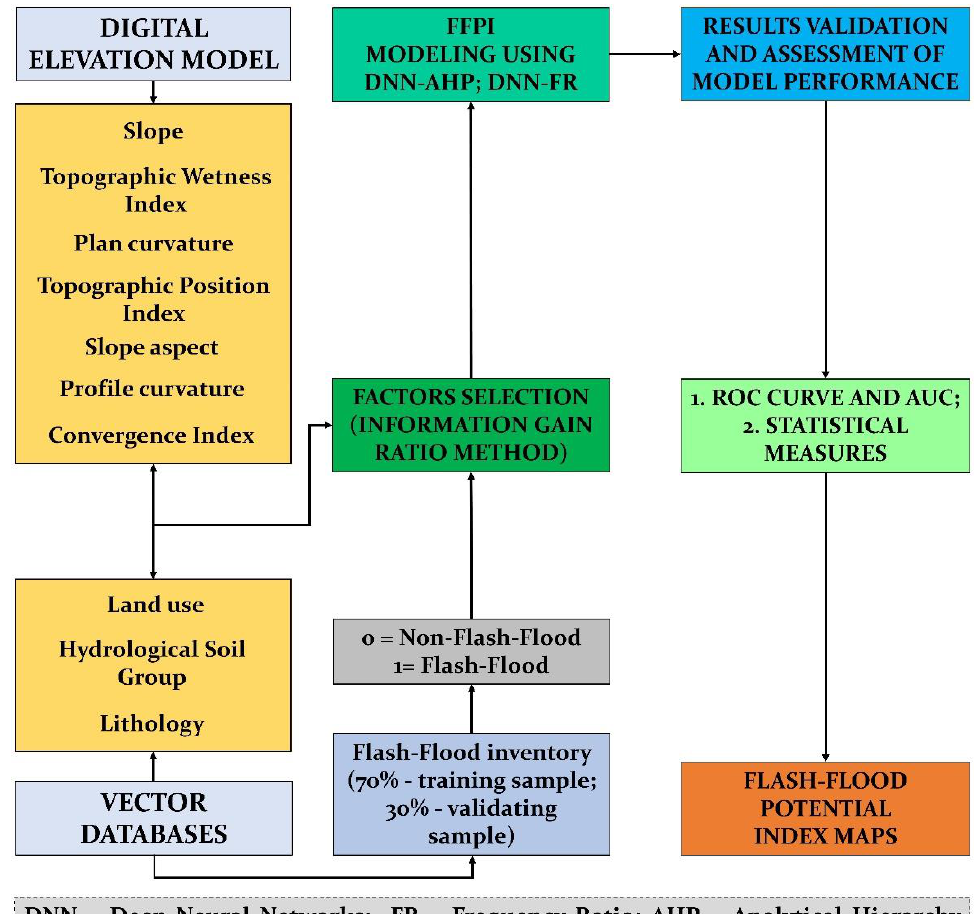
Figure 7. Flowchart of the methodology.